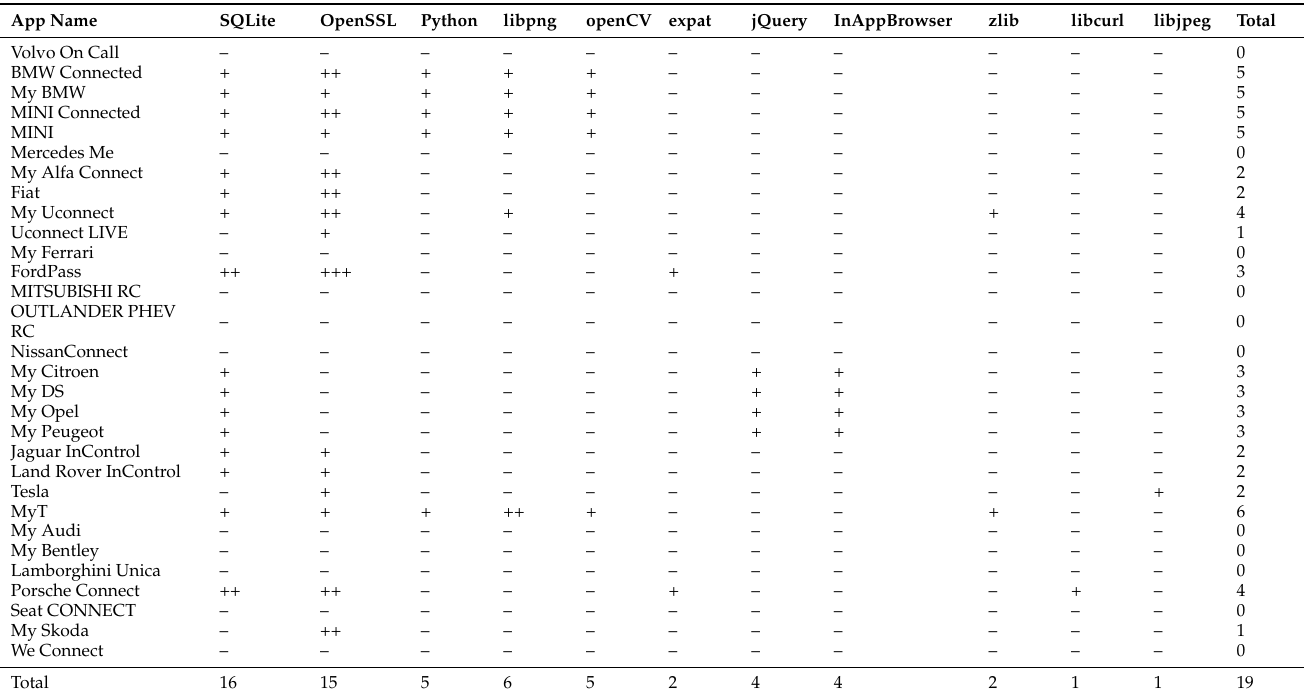
Table 8. Outdated third-party software components per app. The number of plus (+) signs designates how many obsolete versions of the same library exist in that